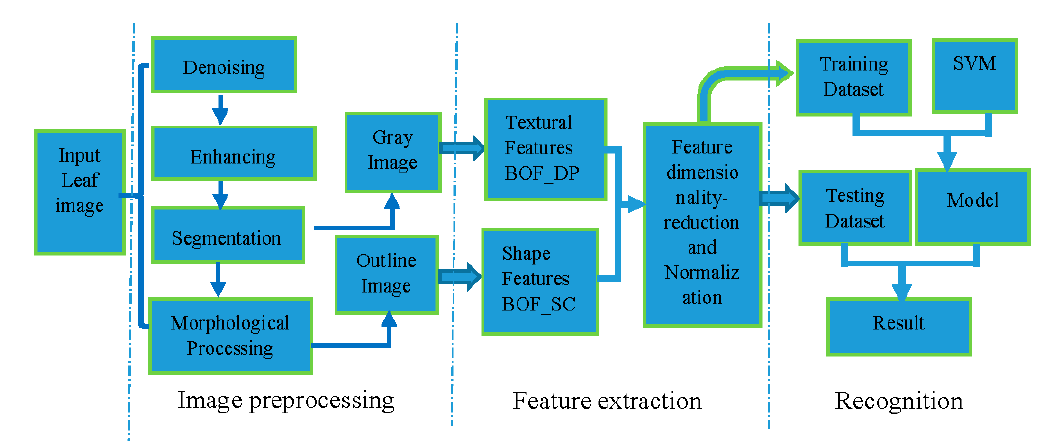
Figure 6. Scheme of the proposed method.